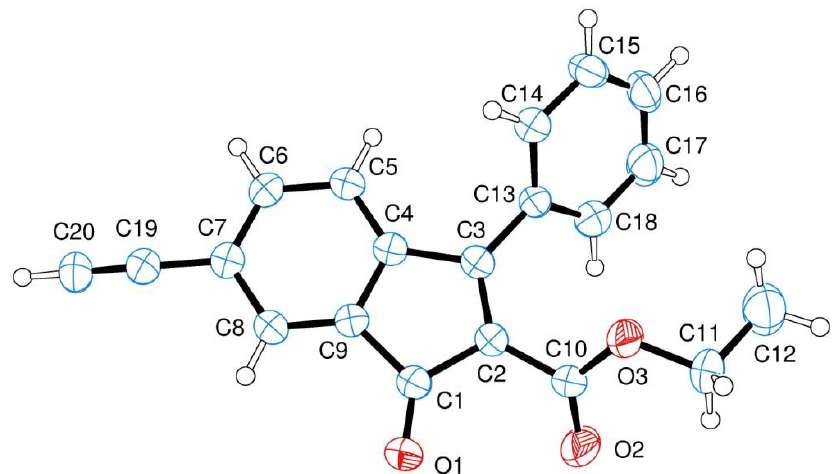
Figure 3. Structure of indenone derivative 3 found by crystallography. Ellipsoids enclose 50% probability.